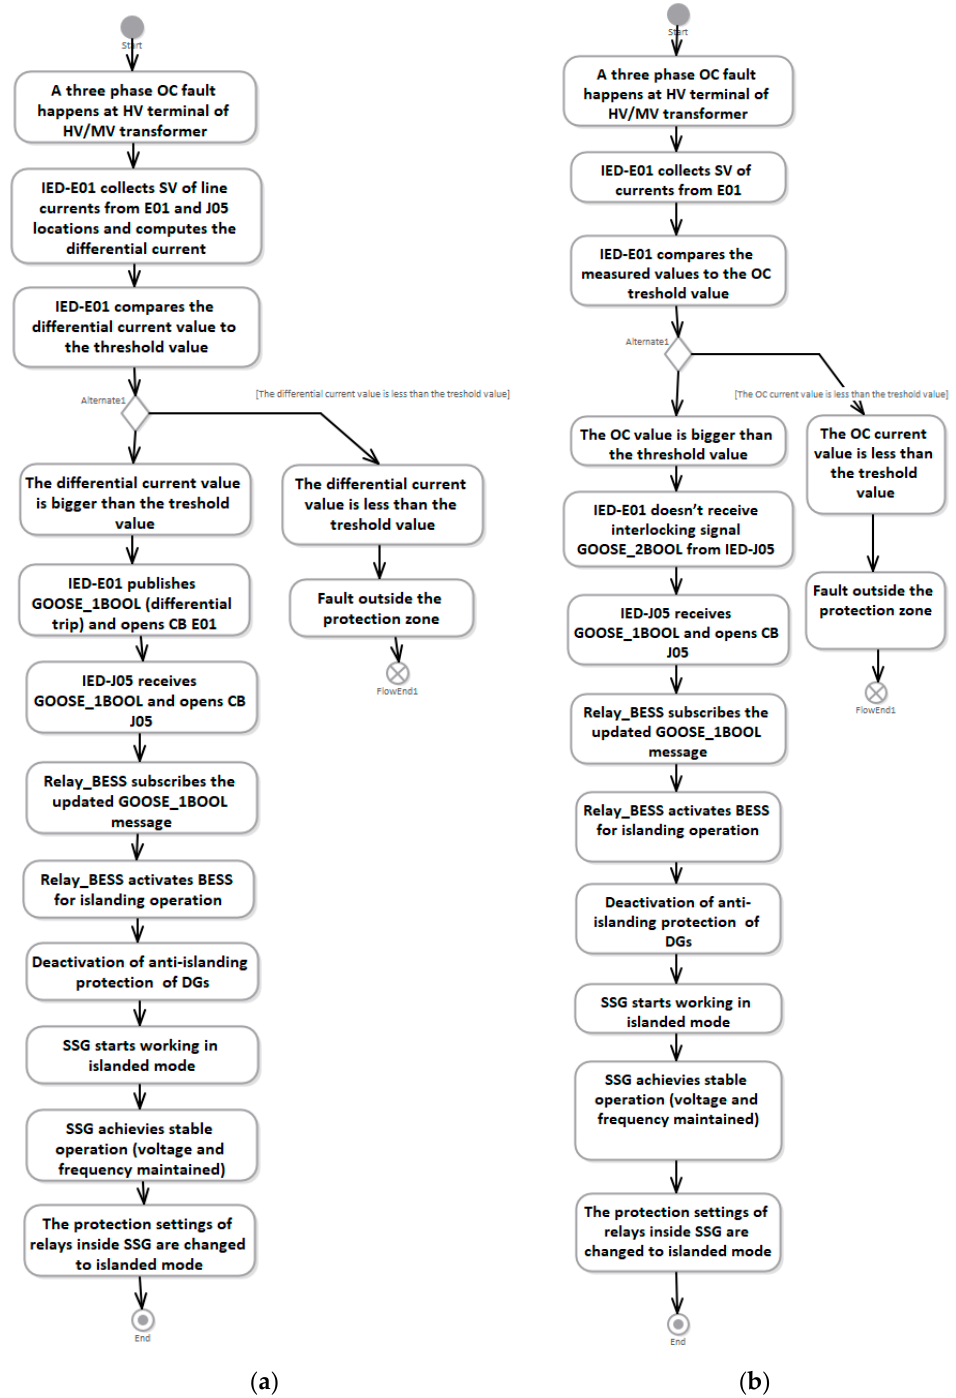
Figure 19. Activity diagram of the overcurrent fault F1 at the transformer terminal TUC: ( a ) main 1 protection; ( b ) main 2 protection.